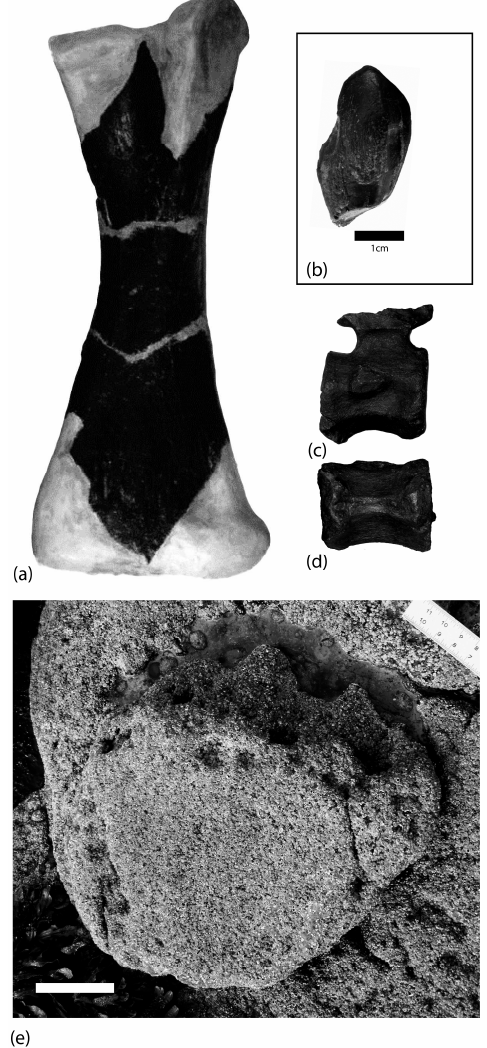
Figure 4. Examples of sauropod remains and tracks from the Trotternish Peninsula, Isle of Skye, ( a ) cast with interpretative reconstruction of sauropod limb bone from the Valtos Formation near Valtos (SM 1977.1994.1) cast in the Hunterian (GLAHM 109385); ( b ) sauropod tooth from the Valtos Formation near Ellishadder (SM 1977.2007.1) cast in the Hunterian (GLAHM 131151) scale = 1cm; ( c ) lateral view and; ( d ) ventral view of the caudal vertebra from the Valtos Formation found on the foreshore north of Ellishadder (SM.1977.1996.1) cast in the Hunterian (GLAHM 109384); ( e ) in situ sauropod footprint from the Duntulm Formation at Cairidh Ghlumaig near Duntulm Castle. ( a , c , d ) and ( e ) to same scale, scalebar = 10